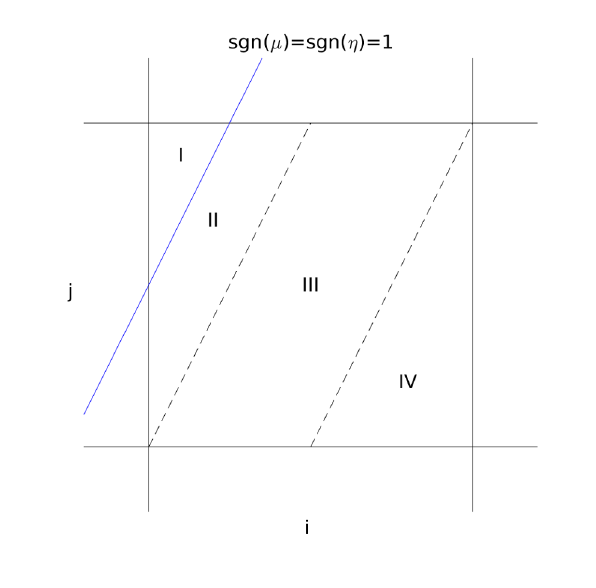
Figure 2: Cell Split into Four Subregions by SCT Scheme